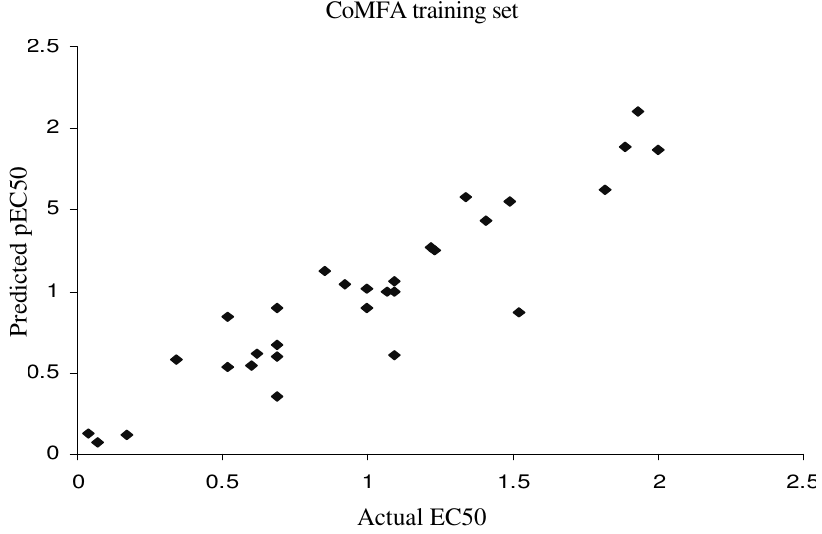
Figure 3. Plot of predicted versus actual EC model.